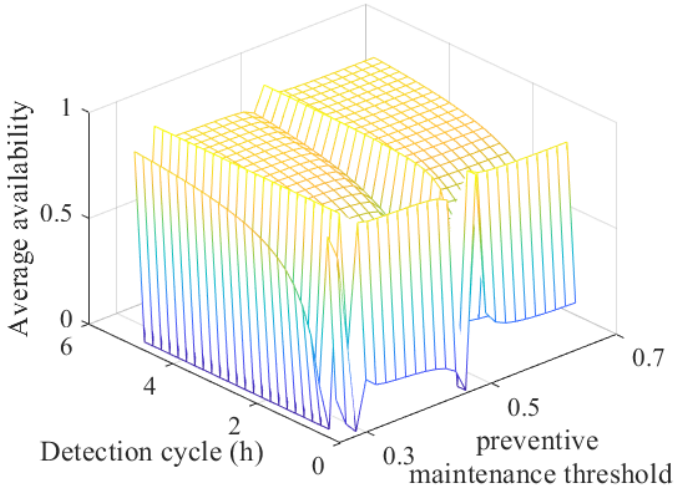
Figure 11. Relationship between variables and availability of joint optimization model .